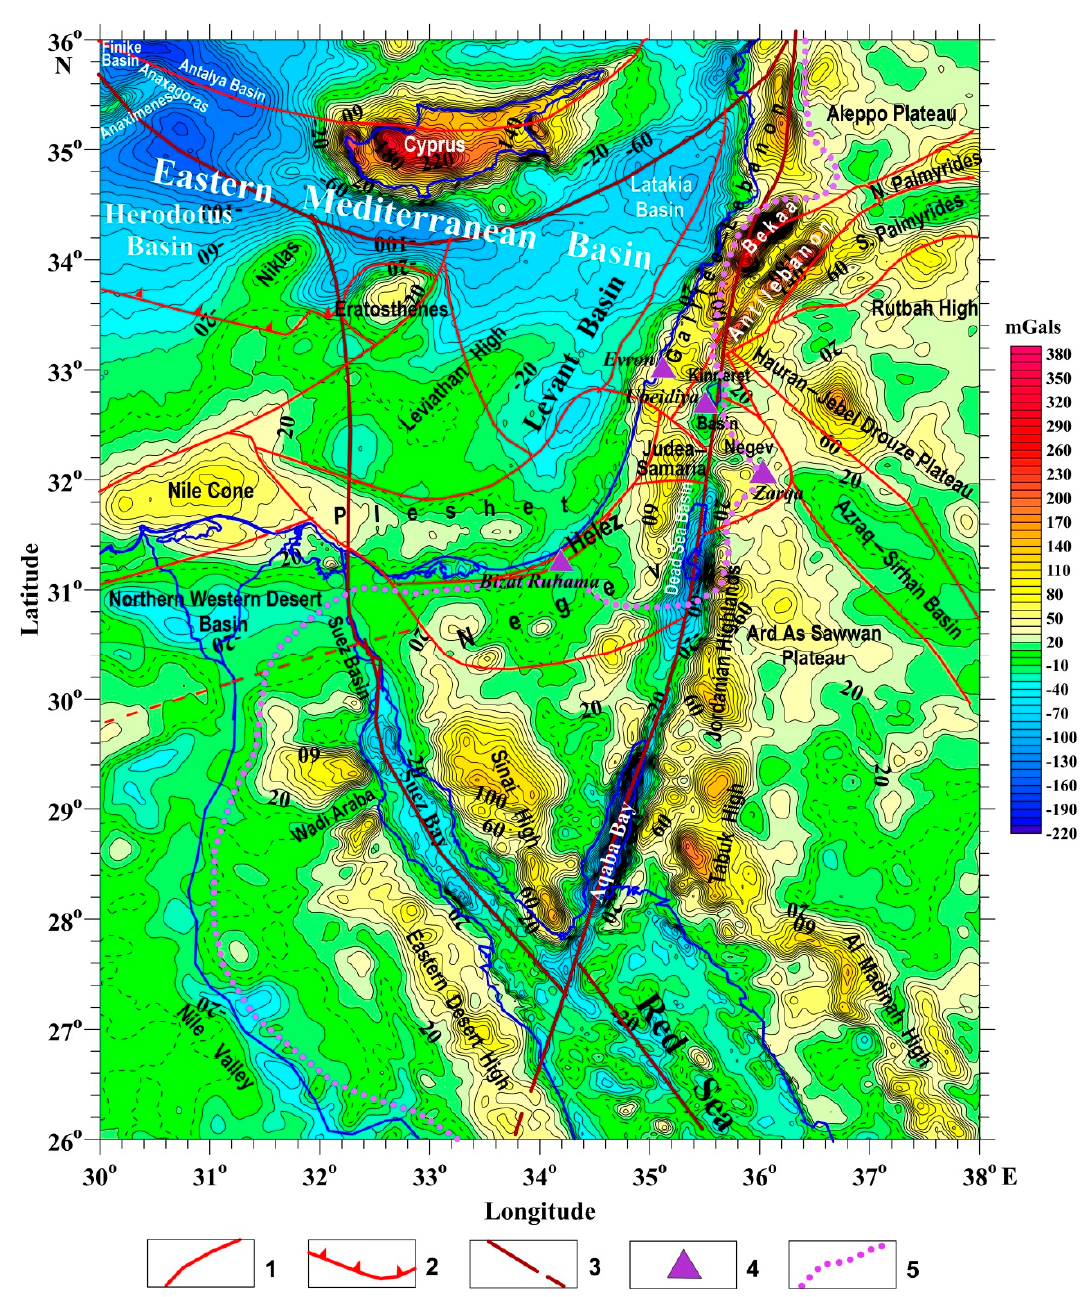
Figure 3. Geodynamic-paleogeographic map of the African-Arabian region with the main tectonic elements and ancient hominin sites. (1) interplate faults, (2) Mediterranean Ridge, (3) intraplate faults, (4) ancient hominin sites corresponding to the age of the Post-Gelasian regression, (5) reconstructed early hominin way from Africa to Eurasia.